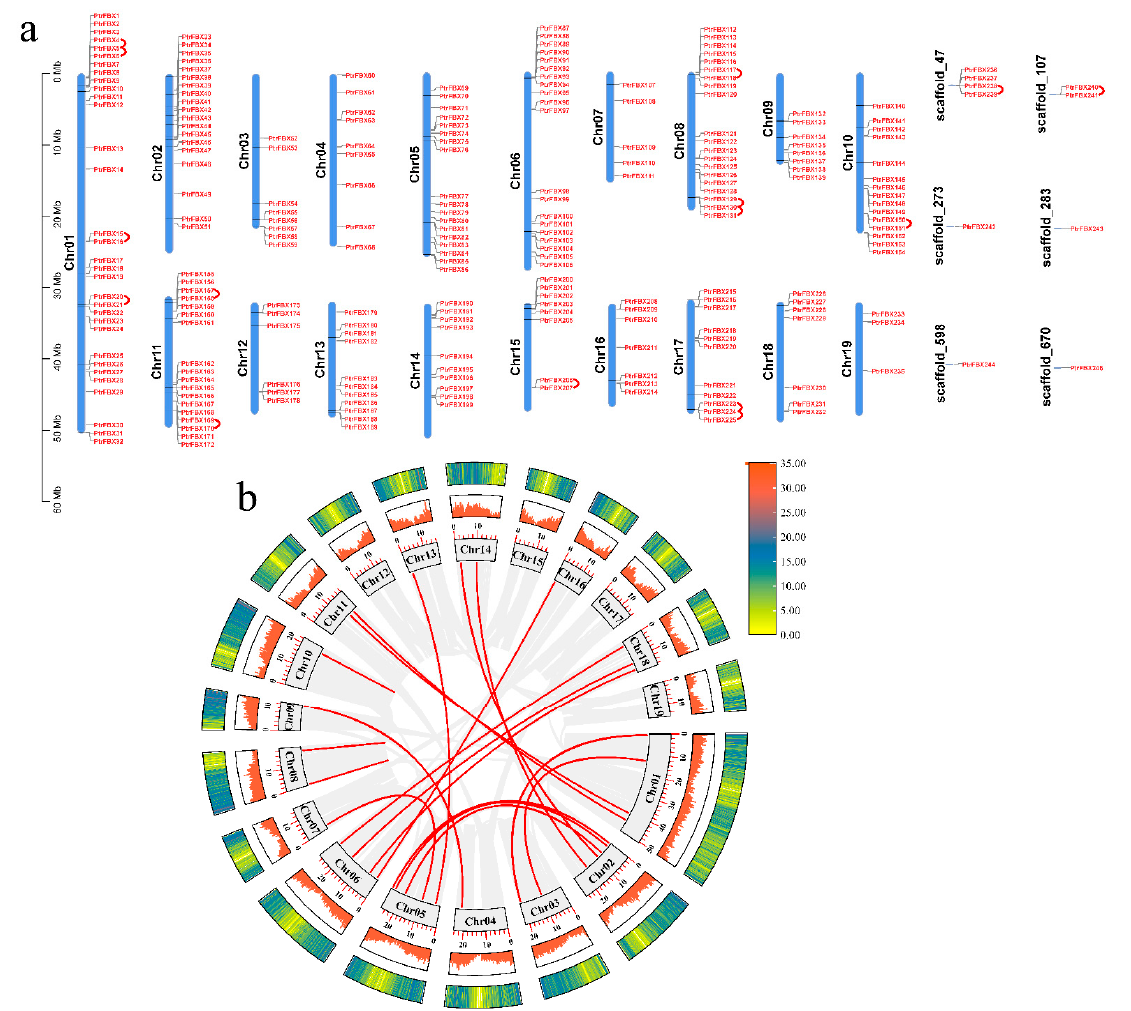
Figure 4. Chromosome location and duplication events of the F-box genes in poplar. ( a ) The distribution of 245 PtrFBX genes on poplar’s chromosomes and scaffolds. Chr 01–19 represents chromosomes 1–19. The chromosomes are drawn to scale and the chromosome numbers are indicated on the left. Gene names are to the right of the chromosomes. The red lines represent tandem duplication gene pairs. ( b ) Circle map of the duplication gene pairs of the PtrFBX genes. The heatmap and the histograms in rectangles represent the gene density on the chromosomes. The red lines represent duplication gene pairs of PtrFBX genes, while the gray lines indicate collinear blocks of all poplar genes.